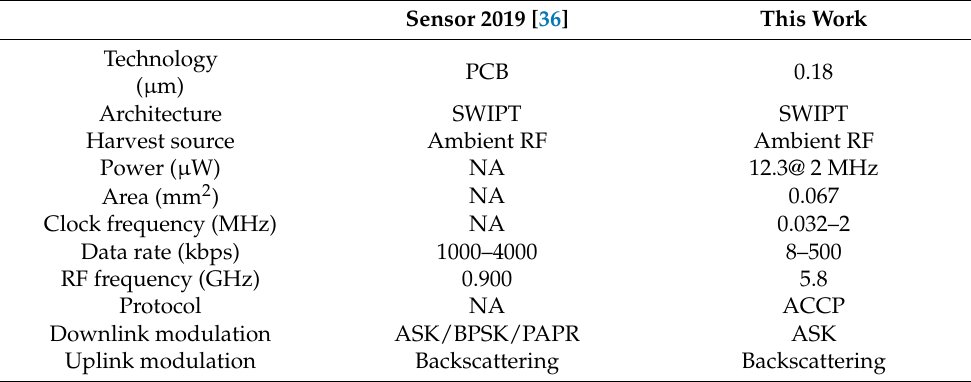
Table 1. Performance comparison with the PCB-based SWIPT.